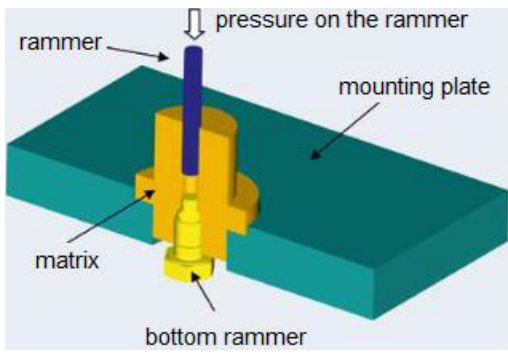
Figure 1. The cold pressing scheme for manufacturing the titanium dioxide specimens by powder